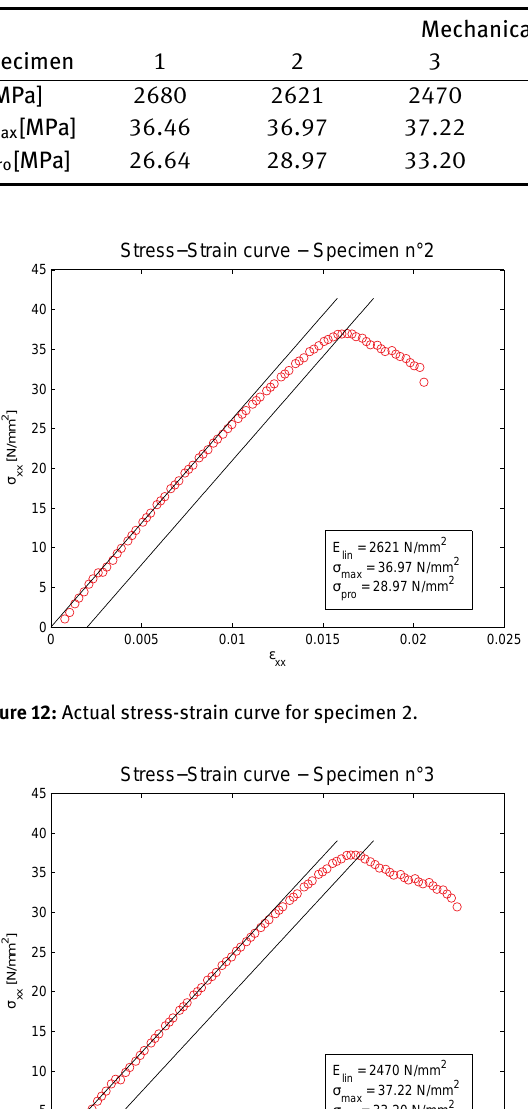
Table 1: Mechanical experimental data for the eight specimens.